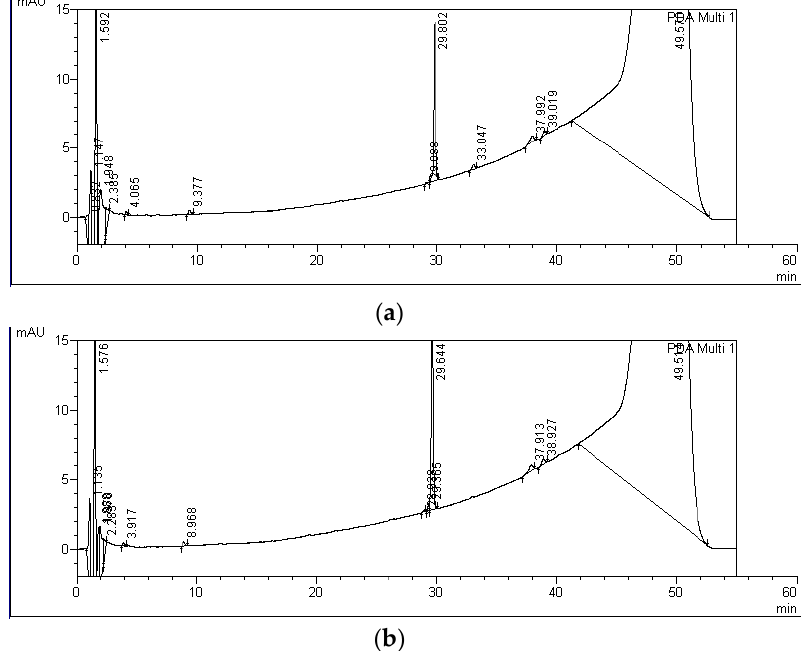
Figure 6. HPLC chromatograms indicating the peaks of MC-LF and its degradation product after four ( a ) and nine days ( b ) of incubation with S. polyrhiza and associated microorganisms. Peaks and their retention times for MC-LF and its degradation product were as follows: A-LF — 28.938 – 29.088 min. and MC-LF — 29.644 – 29.802 min.